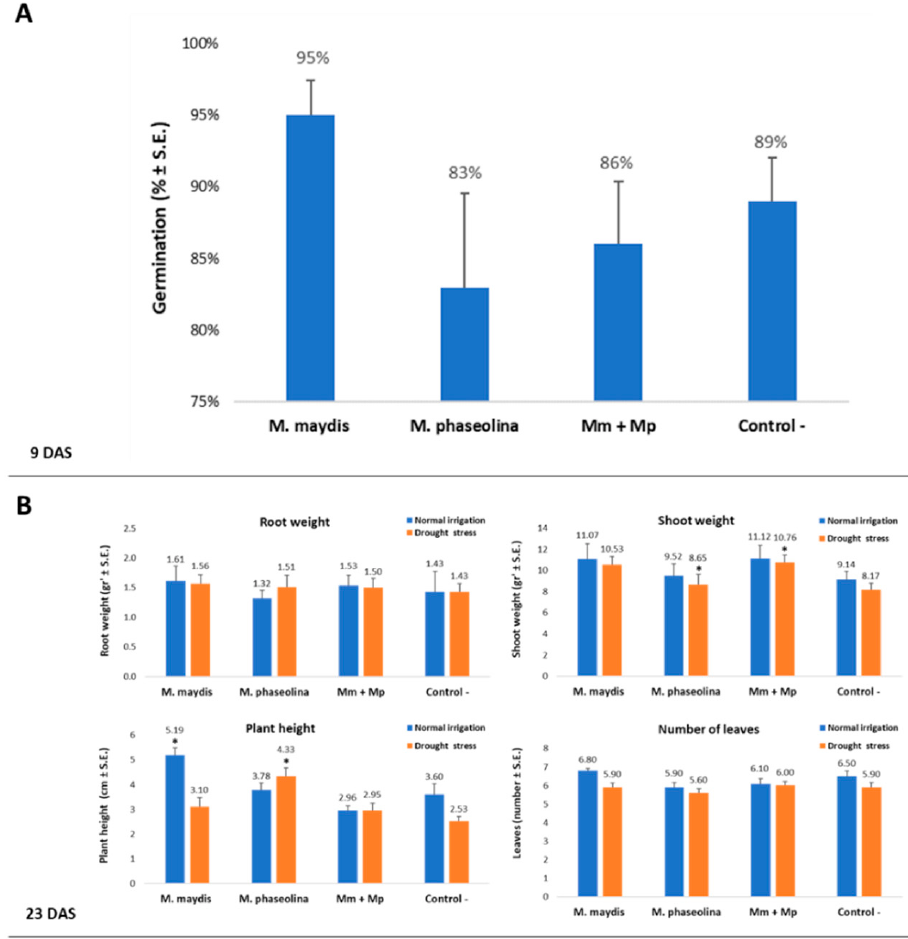
Figure 4. Symptoms evaluation and yield assessment in maize . Plant developmental values and yield assessment was made for the plants in the 2019 experiment described in Figure 2. Sprout emergence, 9 DAS ( A ), phenological stage, 23 DAS ( B ), plant height, 58 DAS ( C ), and growth and yield assessment 79 DAS and 22 DAF ( D ) were determined after the inoculation of the plants with M. maydis and M. phaseolina , alone or in mixed inoculation. Vertical upper bars represent the standard error of the mean of 10 replications (pots, each containing one plant from 23 DAS onwards). When existing, significance from the control (untreated) is indicated as * = p < 0.05.